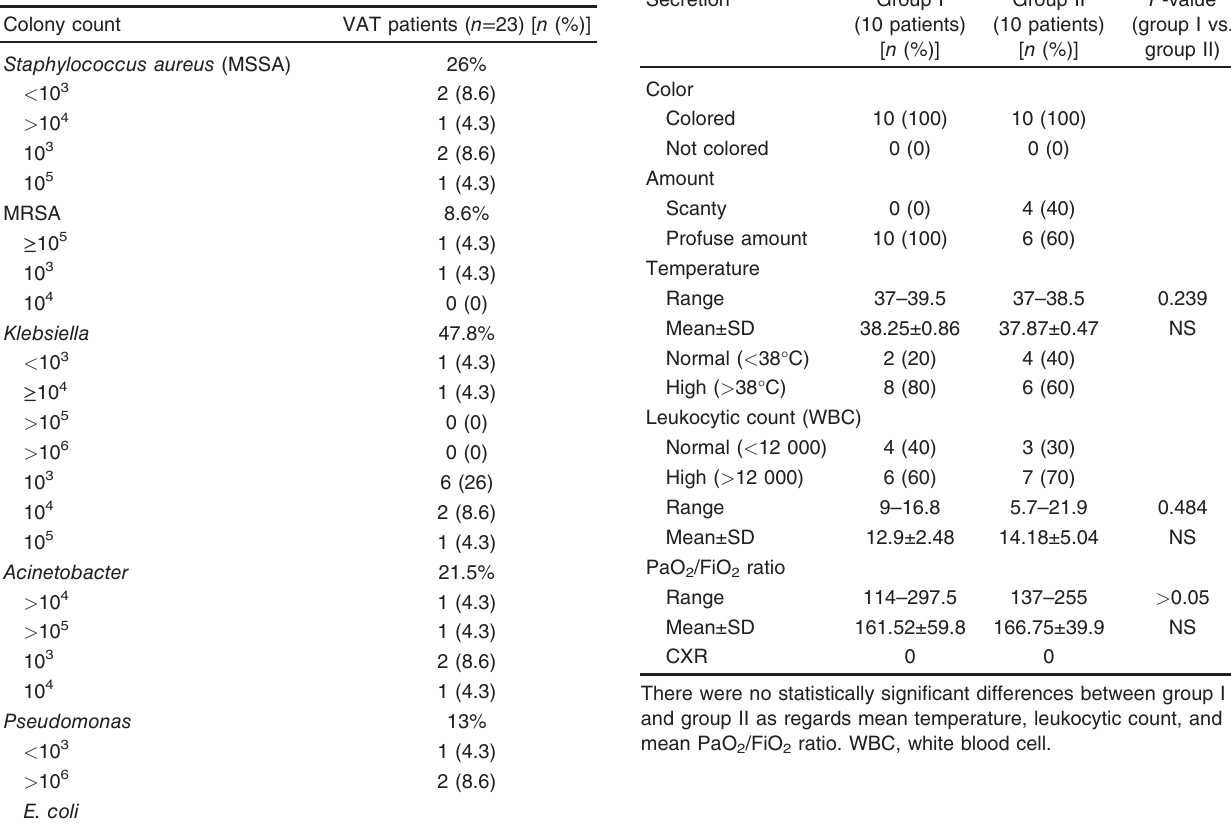
Table 6 Diagnostic criteria of the study groups on day 1 Secretion